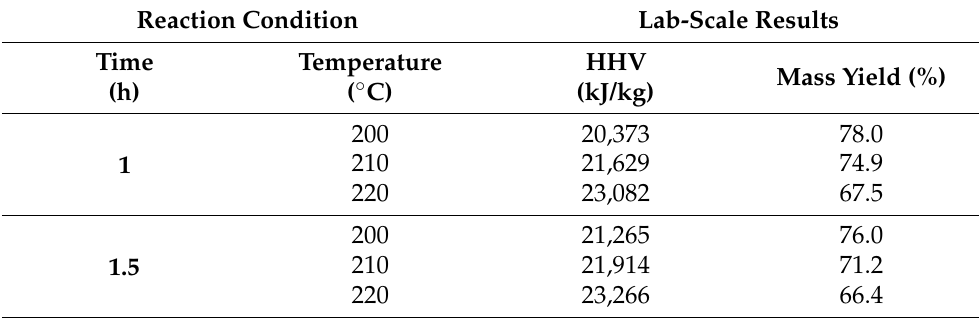
Table 3. Comparison of calorific value and mass yield after HTC of waste wood.